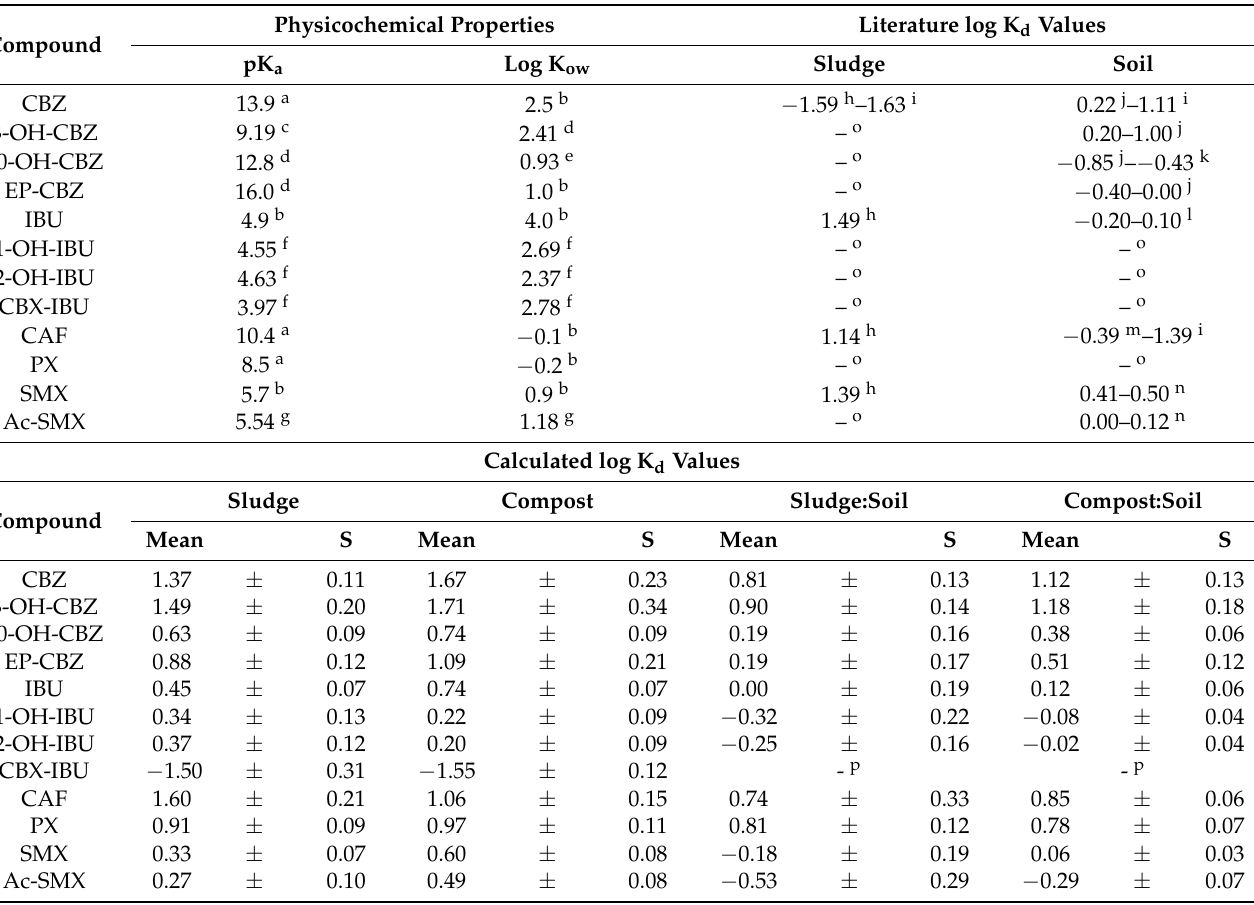
Table 2. Physicochemical properties (log K ow and pK a values) and calculated log K d values of the pharmaceutically active